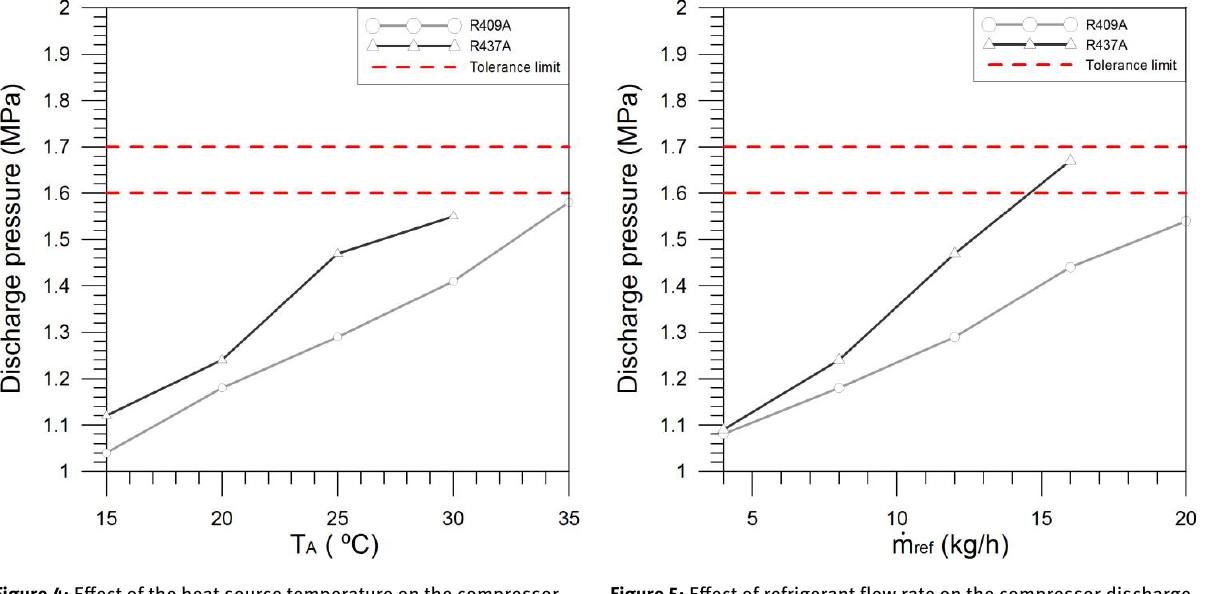
Figure 4: Effect of the heat source temperature on the compressor discharge pressure (Group A of tests).